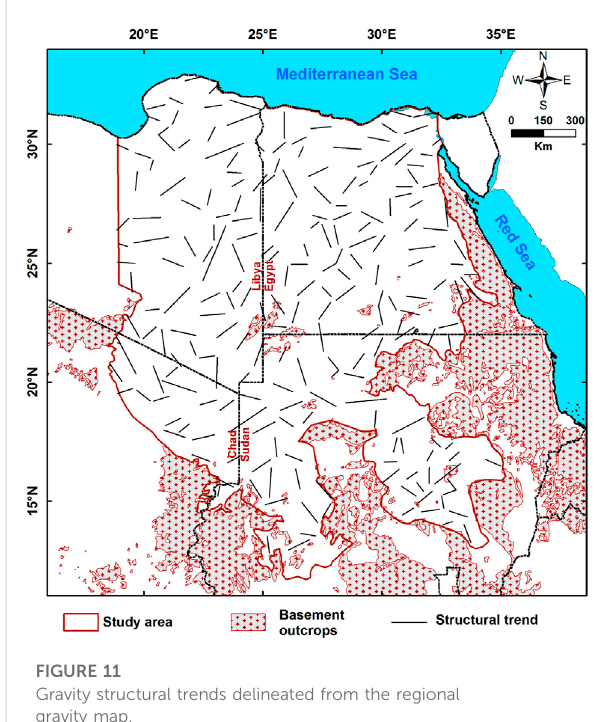
FIGURE 11 Gravity structural trends delineated from the regional gravity